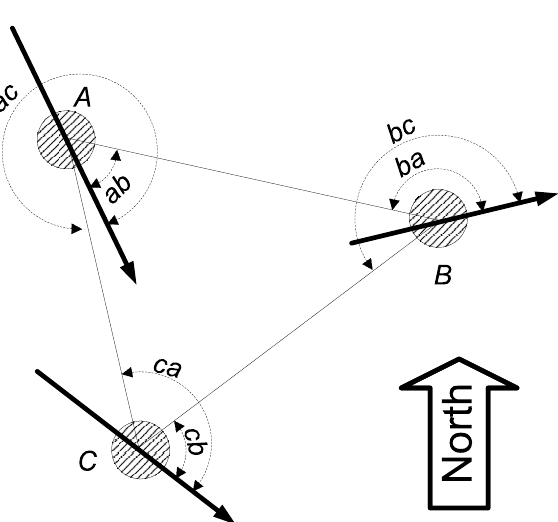
Figure 1. Nodes with AOA